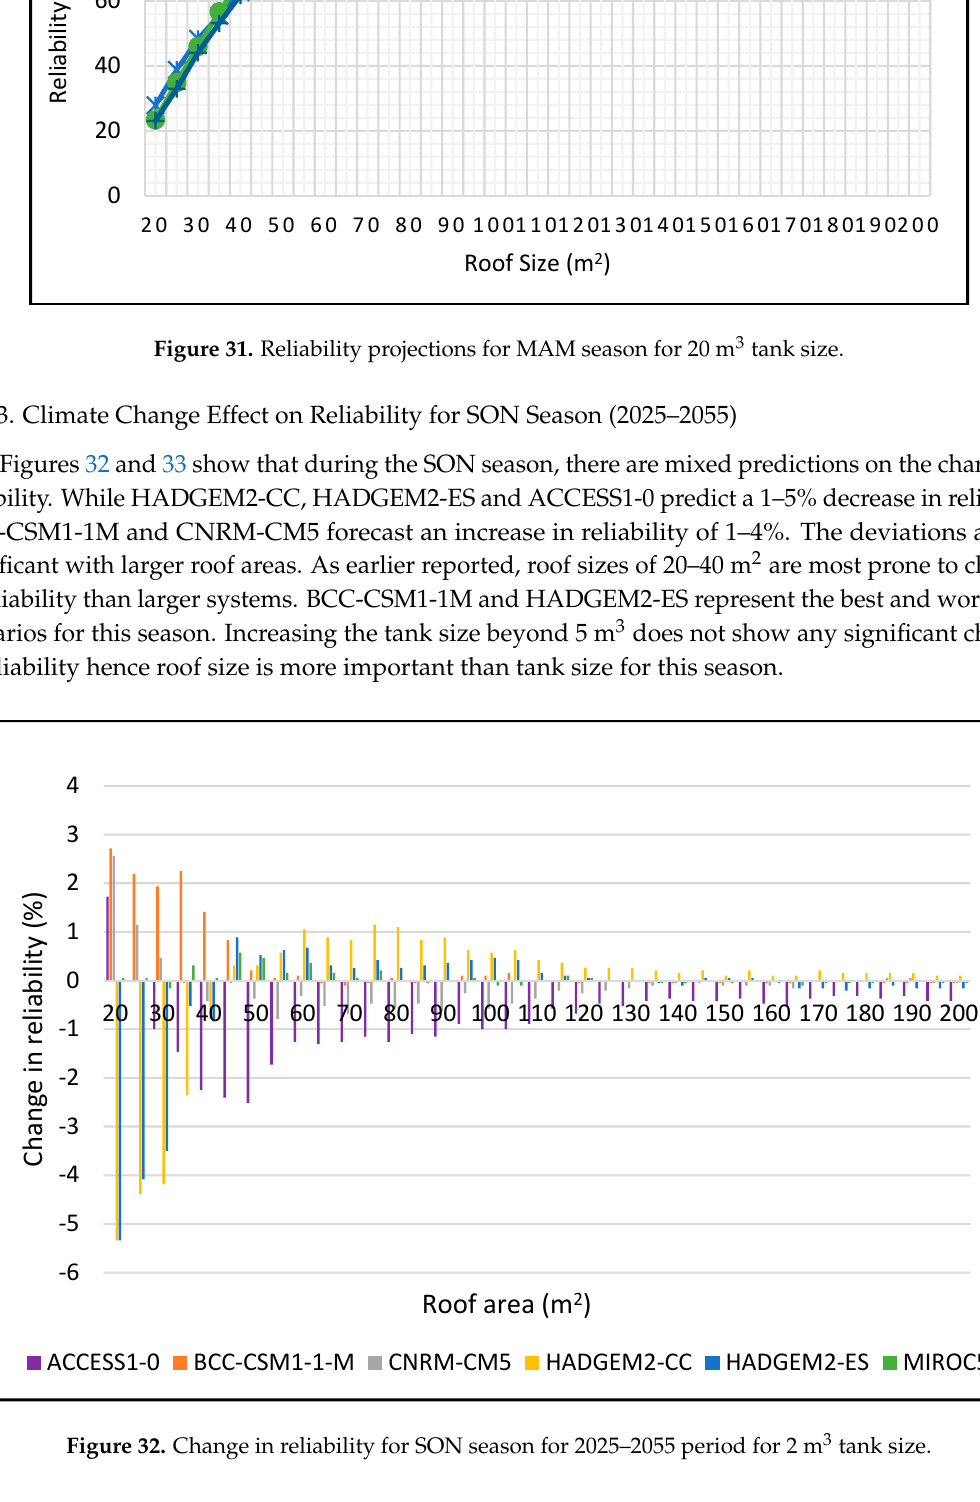
Figure 32. Change in reliability for SON season for 2025–2055 period for 2 m 3 tank size.